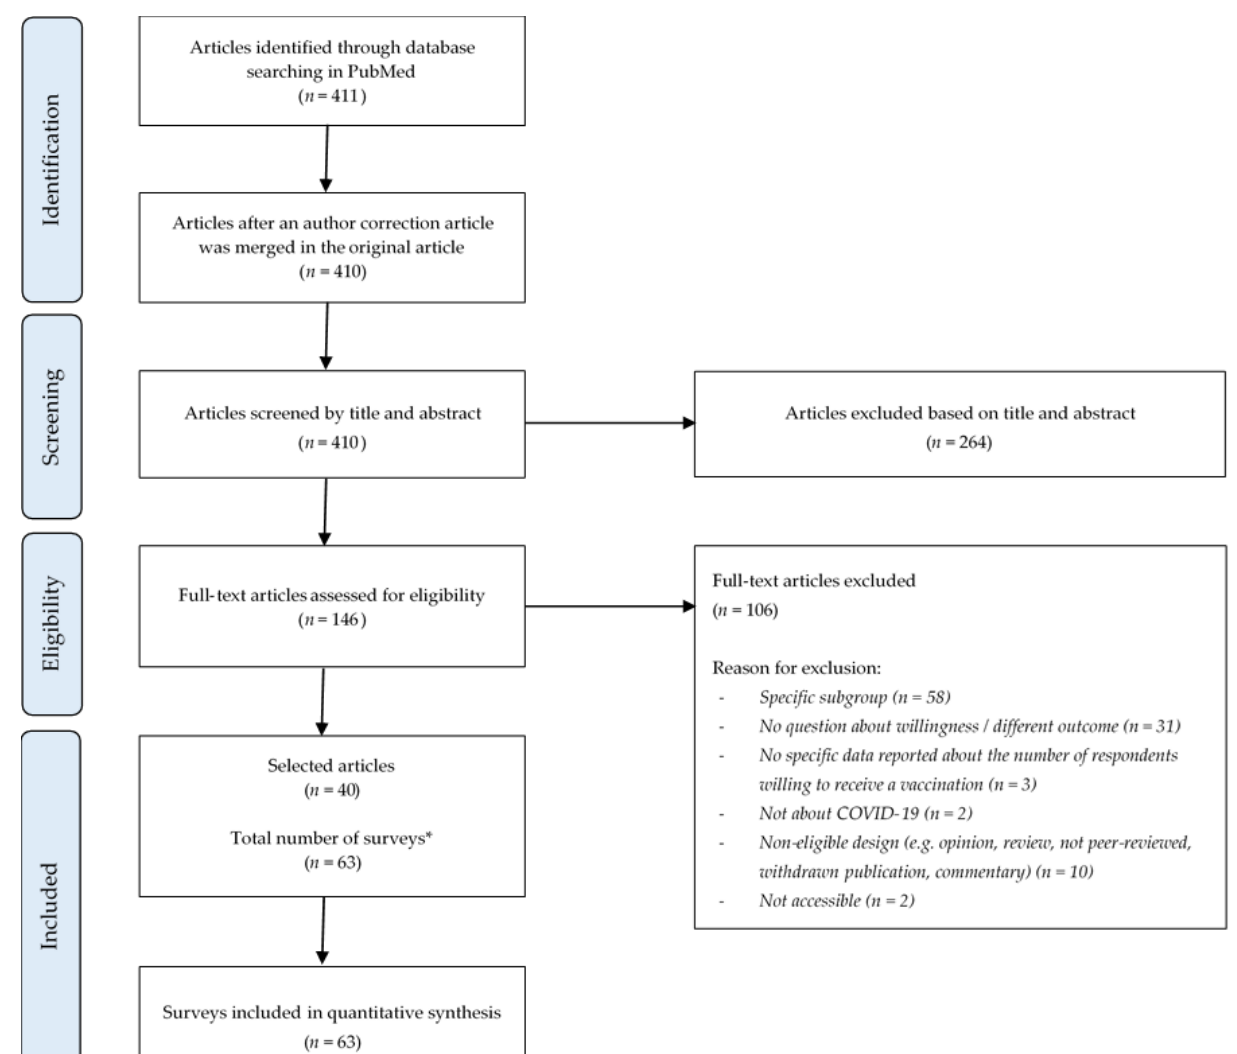
Figure 1. PRISMA flow diagram of study search and selection process. * Some articles described the results of multiple surveys.